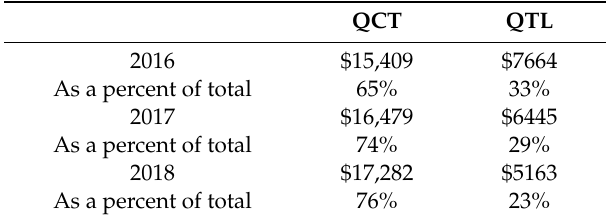
Table 5. Sources of Qualcomm’s Income (in millions, except percentage